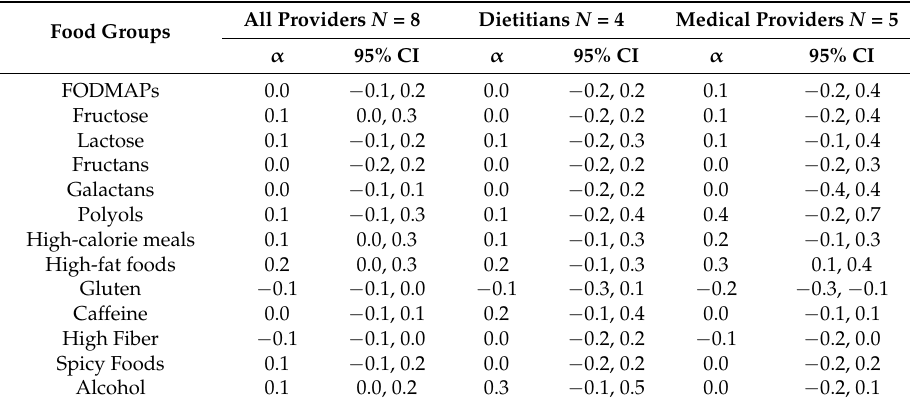
Table 1. Inter-rater agreement of trigger food likelihood ratings amongst providers after reviewing 17 IBS food and symptom journals using Krippendorff α-reliability estimates.